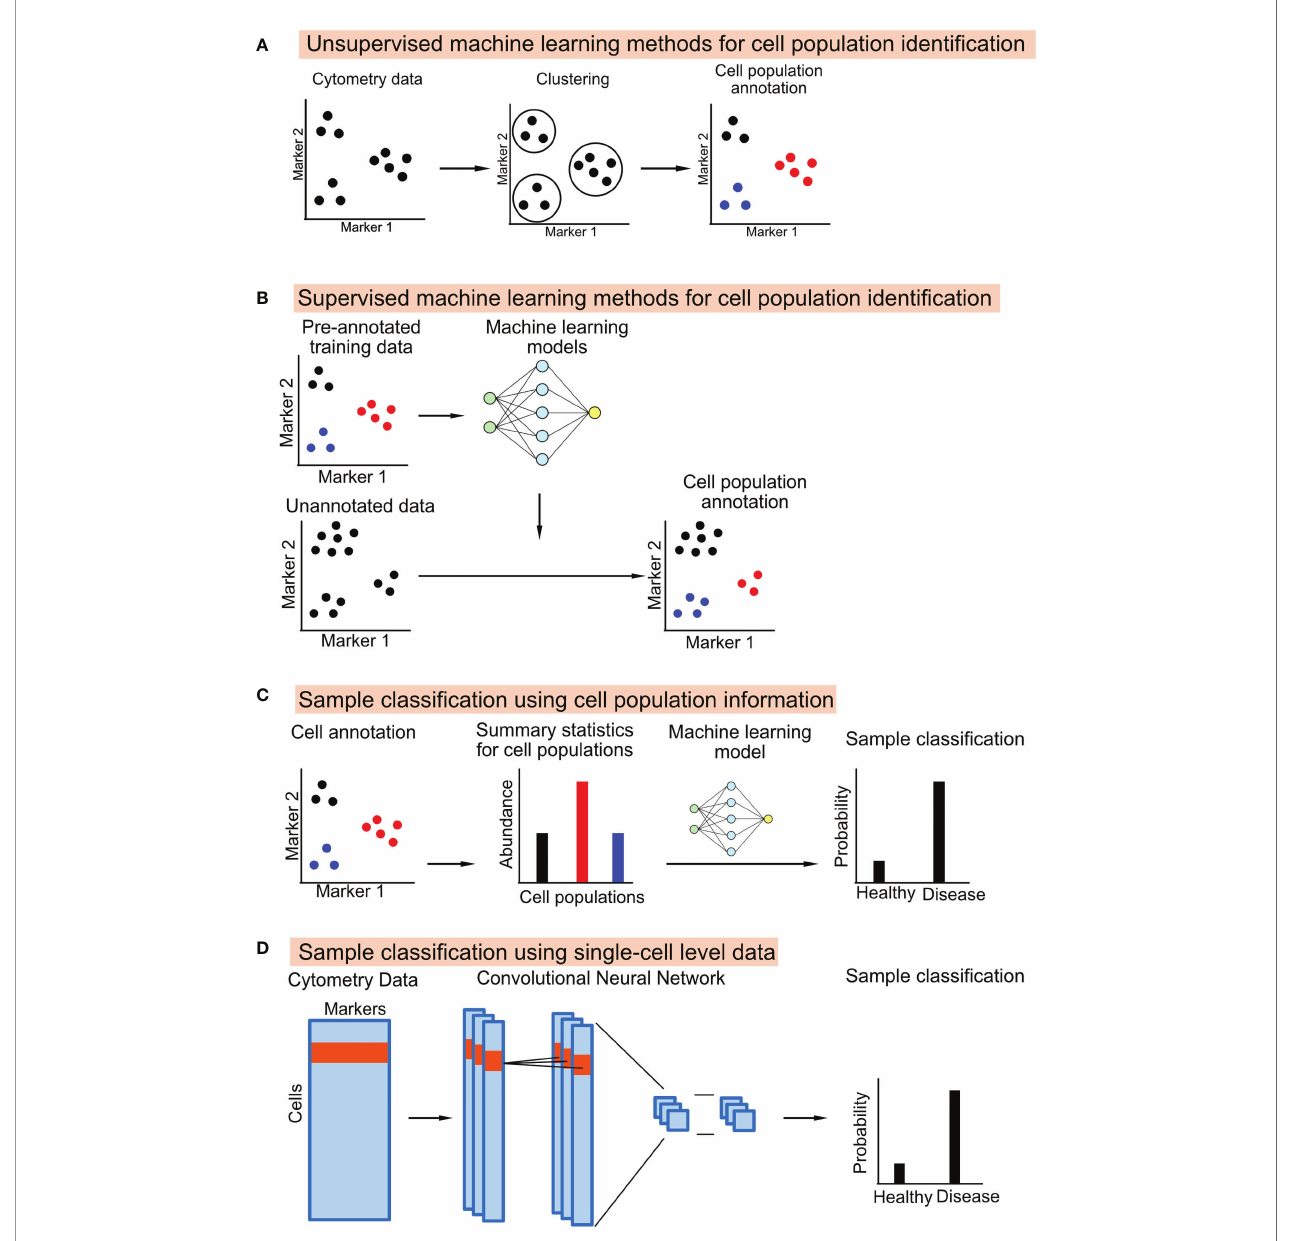
FIGURE 1 | Schematic diagrams showing the machine learning approaches used to annotate cell population from cytometry data or classifying the cytometry